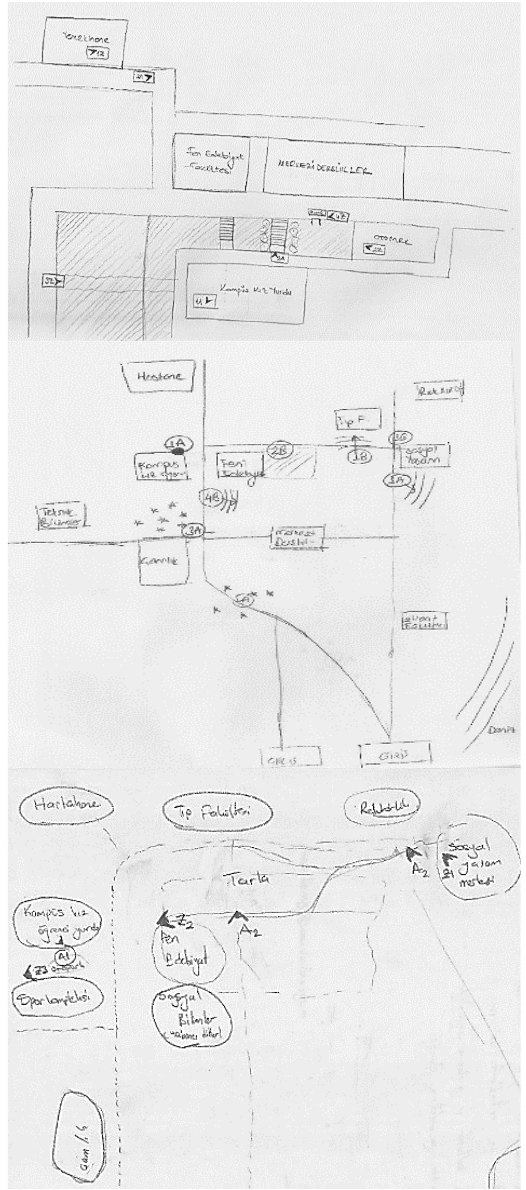
Figure 3. Cognitive map samples of the students from their horizontal campus experiences: Drawing of near scale (a), Detailed connection drawings (b), Descriptive scheme